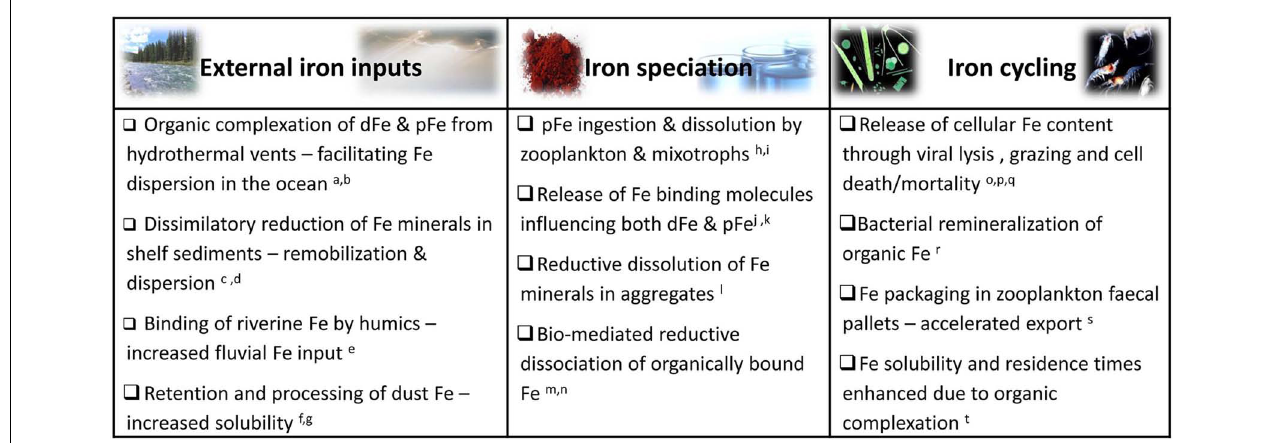
dissolved iron; cFe, colloidal iron; pFe, particulate Fe. References: a Sander and Koschinsky (2011), b Wu et al. (2011), c Lohan and Bruland (2008), d Severmann et al. (2010), e Batchelli et al. (2010), f Boyd et al. (2010b), g Rubin et al. (2011), h Barbeau et al. (1996), i Tang et al. (2011), j Sato et al. (2007), k Buck et al. (2010), l Balzano et al. (2009), m Maldonado and Price (1999), n Shaked et al. (2002), o Higgins et al. (2009), p Strzepek et al. (2005), q Tsuda et al. (2007), r Boyd et al. (2010a), s Boyd and Ellwood (2010), t Kuma et al.